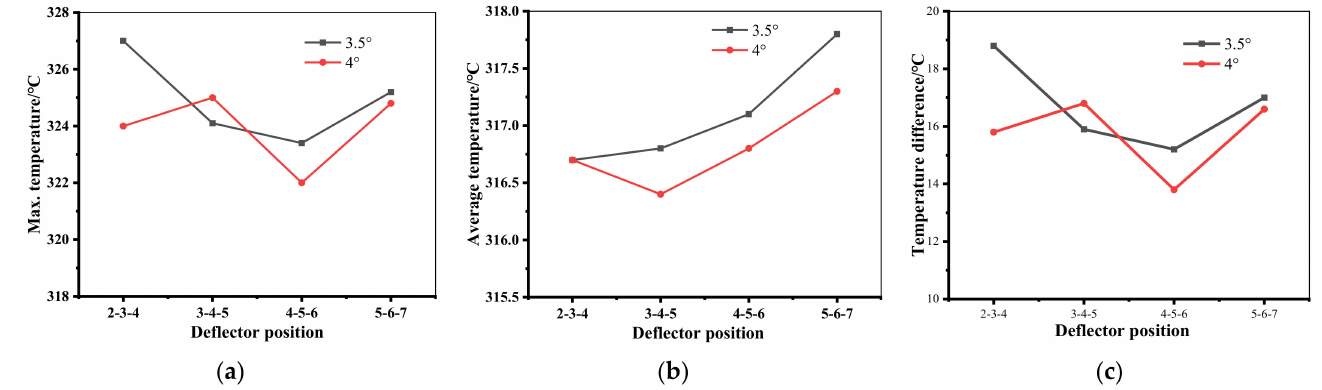
Figure 19. Temperature change curves for the battery pack: ( a ) the maximum temperature change curve; ( b ) the average temperature change curve; and ( c ) the temperature difference